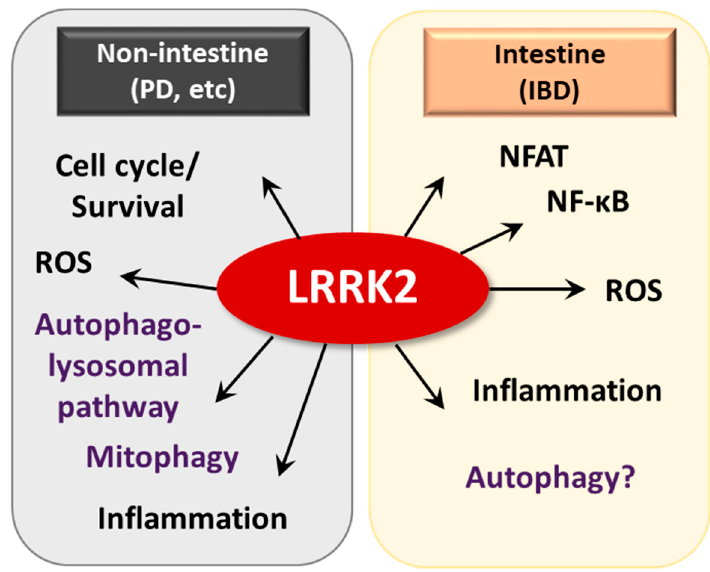
Figure 5. The pathogenic roles of LRRK in non-intestine and intestine diseases. In Parkinson’s disease, LRRK2 is involved in cell cycle/survival, ROS generation, autophagolysosomal pathway, mitophagy and inflammation. LRRK2 plays a key role in intestine homeostasis through regulating NFAT, NF- κ B, ROS generation, inflammation and autophagy.